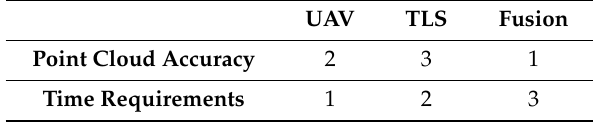
Table 5. Performance evaluation of the three volume computation methods (ranked from 1 to